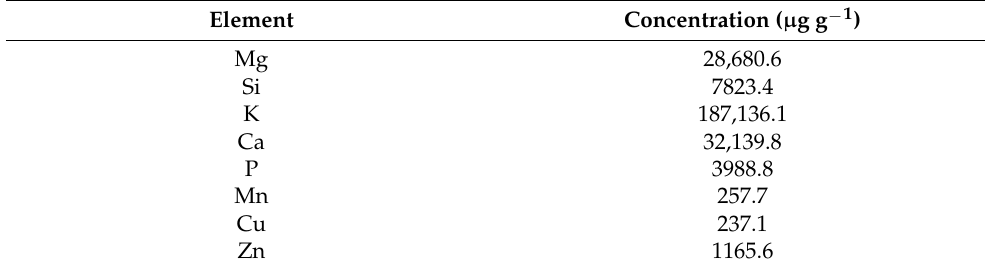
Table 4. Concentrations of minerals in S4 (EtOH-W) extract.